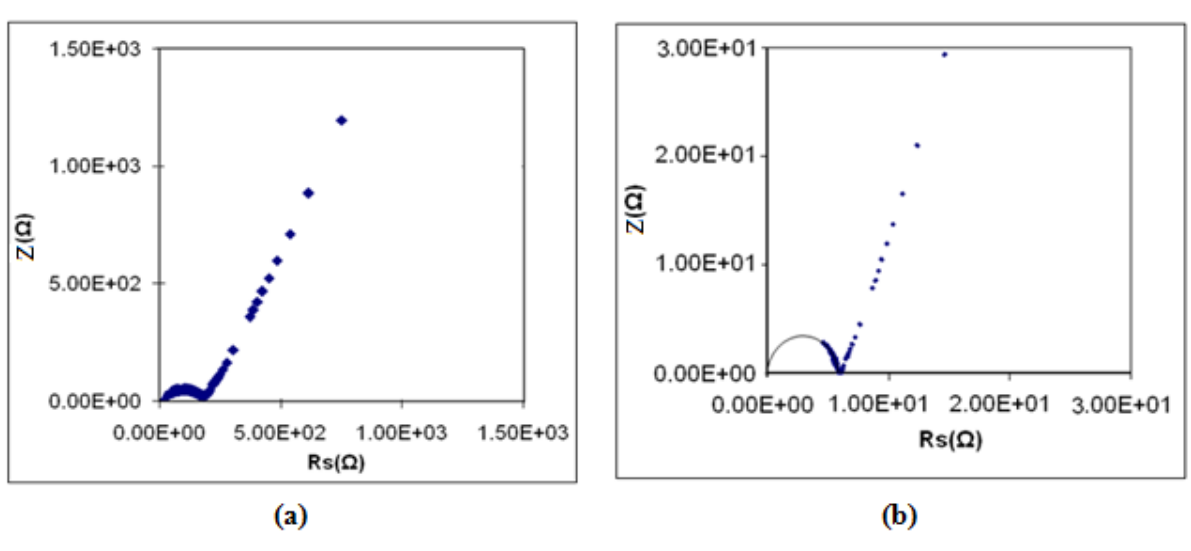
Figure 4. Complex impedance plot for ( a ) PEMA-NH containing 35 wt % BMATFSI films.